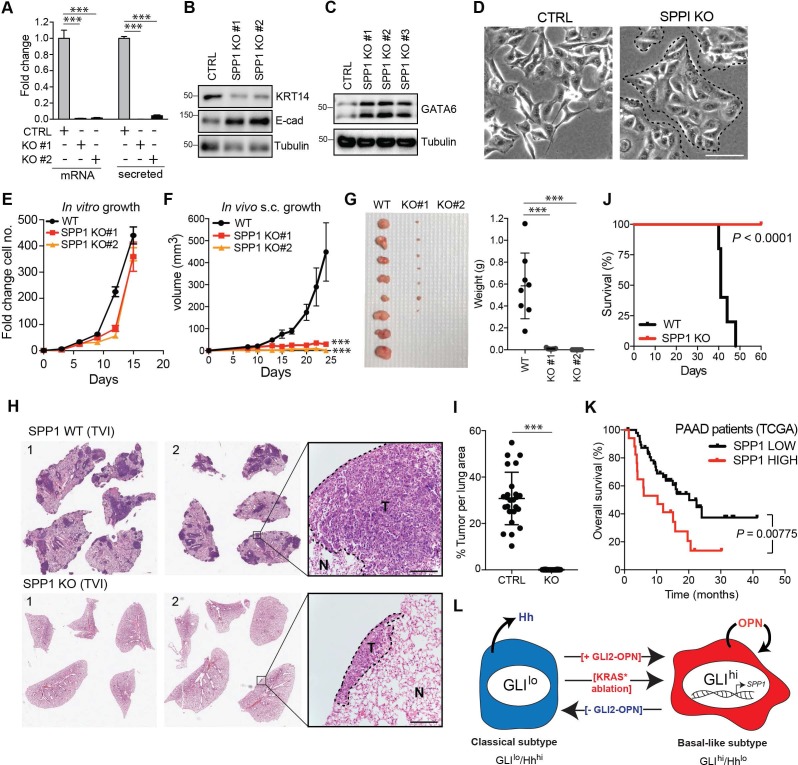
OPN loss impairs growth of basal-like PDA.(A) CRISPR-Cas9-mediated knockout of SPP1 in KP4 cells leads to a decrease in mRNA expression and secreted Osteopontin in two independent clones. (B,C) Immunoblot of KRT14 and E-cadherin (B) and GATA6 (C) levels following KO of SPP1 in KP4 cells. (D) Brightfield images of KP4 cell morphology when grown in 2D monolayer following KO of SPP1. Note the switch to a more epithelial phenotype in the KO cells. Scale bars, 100 μm. (E) In vitro growth rate of KP4 control versus SPP1 KO cell lines. Error bars represent s.e.m. (F) Growth rate of control and SPP1 KO KP4 cells following subcutaneous injection into the flank of NOD/SCID mice. Error bars represent s.e.m. (G) Relative size of control and SPP1 KO KP4 xenografts resected at day 25 (left) and comparative tumor weight (graph at right). (H) Representative H and E stained sections of lungs at endpoint following tail vein injection (TVI) of 2 × 106 KP4 control cells (WT; top) or SPP1 KO (bottom) into NOD/SCID mice. Scale bars, 400 μm. (I) Quantification of metastatic tumor burden in the lungs as a percentage of total lung area per mouse (n = 5 CTRL; n = 10 SPP1 KO). (J) Kaplan-Meier graph depicting survival of NOD/SCID mice following TVI of KP4 WT (black) or SPP1 KO cells (red). (K) High expression of SPP1 in basal-like PDA patient tumors from TCGA predicts shorter overall survival (SPP1 high n = 17, SPP1 low n = 48). Data from 65 patients. (L) Model depicting a classical to basal-like switch mediated by a GLI2-OPN signaling axis and in response to KRASG12D ablation. The classical and basal-like subtypes are marked by GLIlo/Hhhi and GLIhi/Hhlo expression, respectively. p-Value calculated by Log-rank test and by two-tailed unpaired t test. *p<0.05; **p<0.01; ***p<0.001.10.7554/eLife.45313.022Figure 7—source data 1.OPN loss impairs growth of basal-like PDA.